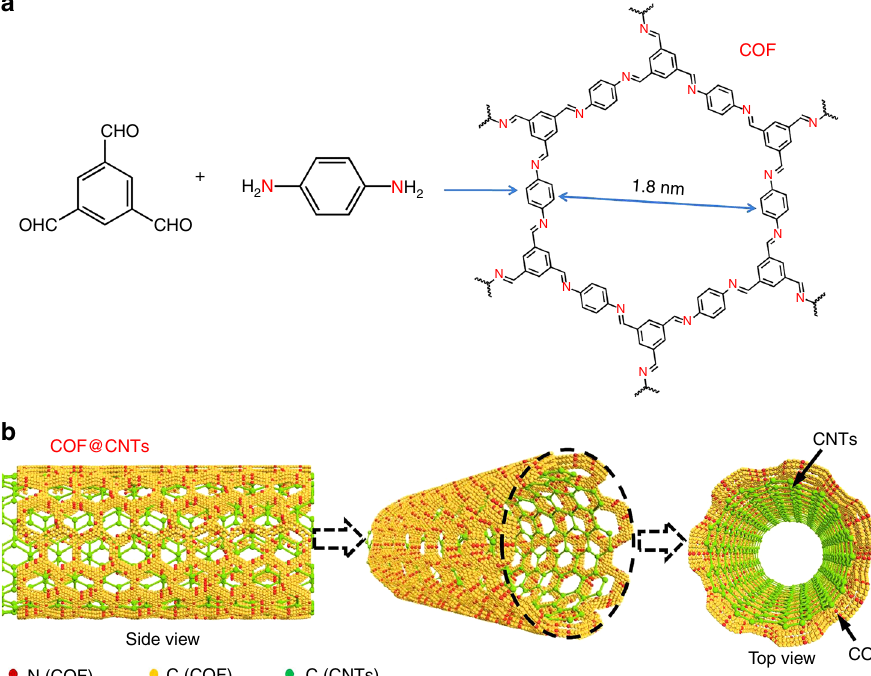
Fig. 1 Construction of COF and COF@CNTs. a Construction of COF. b Graphical representation of COF@CNTs with few COF layers covered on the exterior surface of